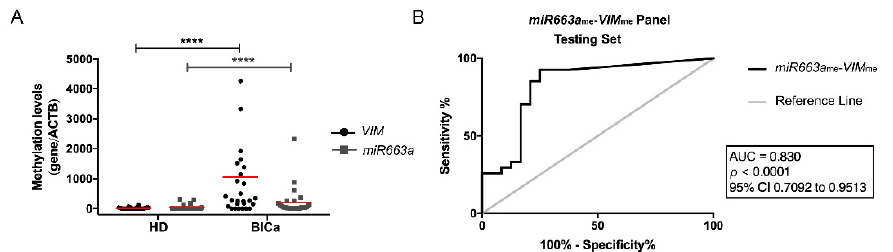
Figure 2. ( A ) Distribution of VIM me and miR663a me levels in the Testing Cohort, composed by healthy donors (HD; n = 24) and bladder carcinoma (BlCa; n = 27) urine samples. Mann-Whitney U test, **** p < 0.0001. Median is represented by the red line. ( B ) Receiver operator characteristic (ROC) curve evaluating the performance of the VIM me - miR663a me panel for the identification of BlCa in urine samples of the Testing Cohort. (AUC—Area under the curve; CI—Confidence interval; ACTB—Beta-Actin; VIM—Vimentin).